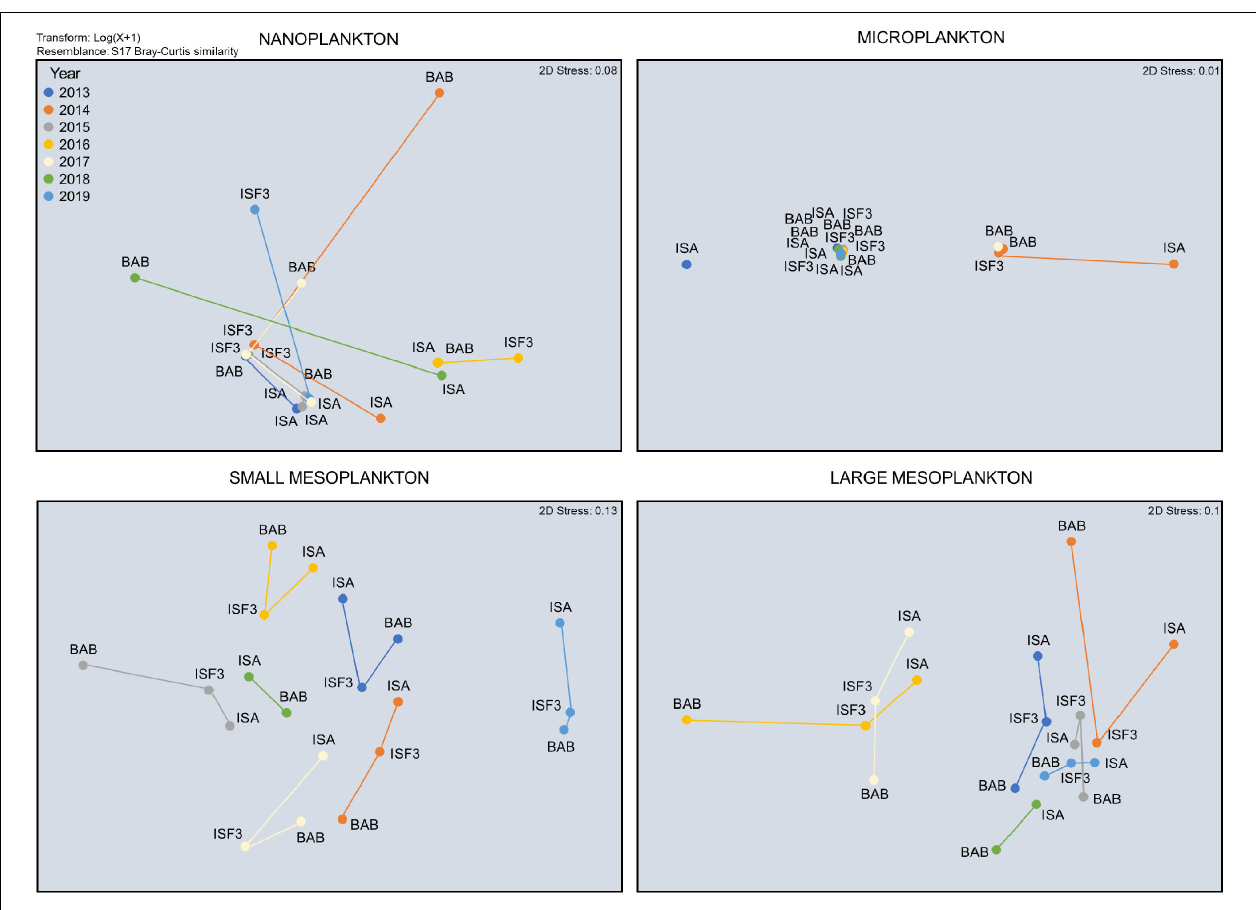
FIGURE 5 | Non-metric MDS scaling of Bray–Curtis resemblance of the composition of dominating taxonomical groups within particular plankton size fractions.